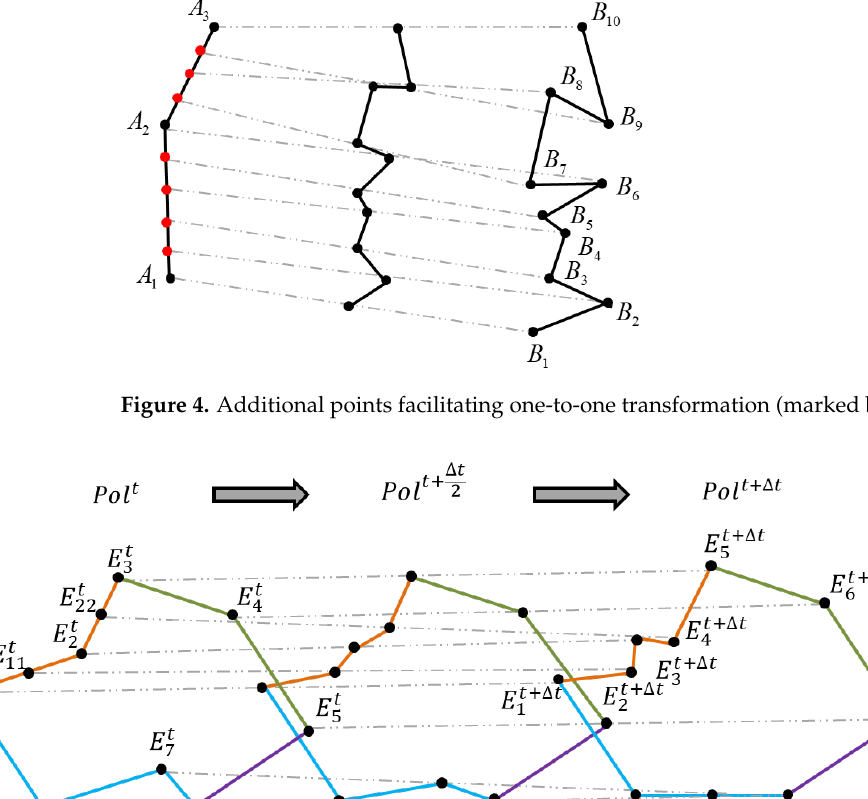
Figure 5. Visualization of one morphing intermediate step at the time moment t + t 0 to decomposition of boundaries into four parts (marked by different colors) .